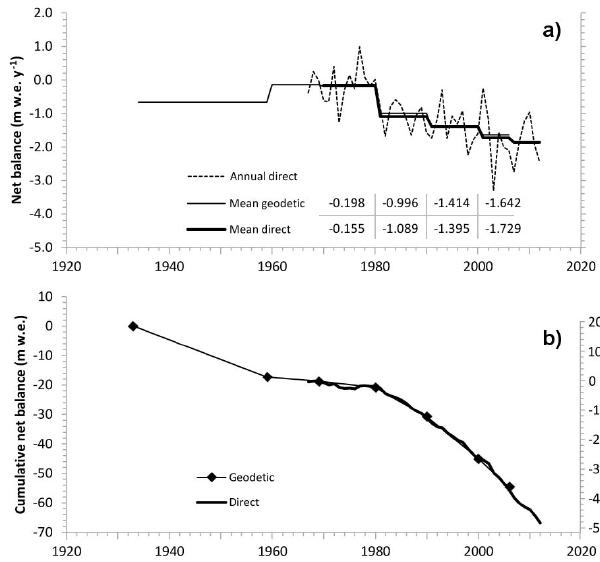
Fig. 8. Annual (a) and cumulative (b) net balance of the Careser Glacier, calculated by the geodetic and direct methods, ending in 2006 and in 2012 respectively. In the lower diagram the geodetic curve has zero value when it begins, and the direct curve (secondary y axis) has been plotted so that it matches the geodetic curve in